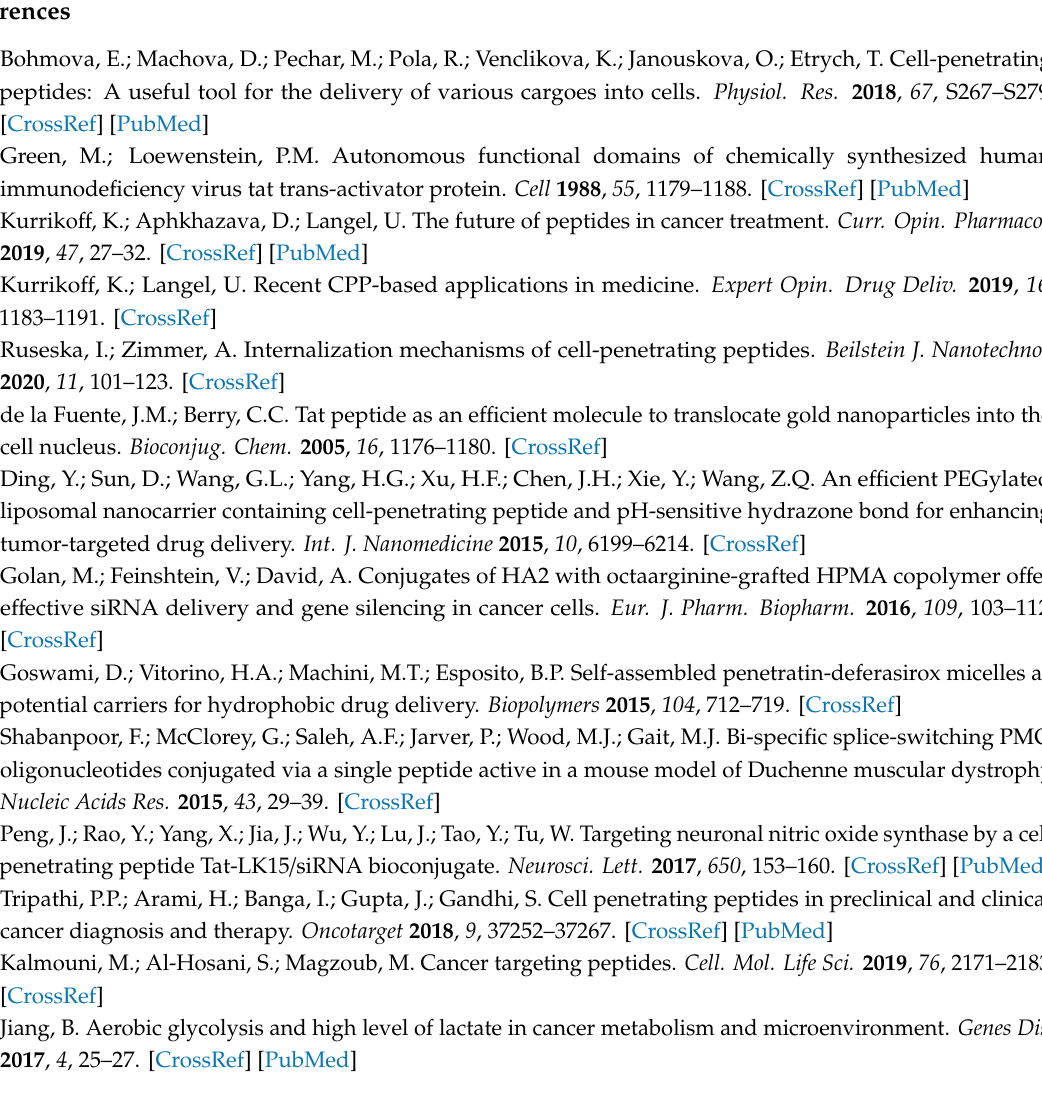
each condition, adj. p -value ≤ 0.05 is marked by grey color, upregulated genes (log2(FC) ≥ 0.5) are marked by green color and downregulated genes (log2(FC) ≤ − 0.5) are marked by red color, Table S3: Clustering analysis of transcriptomic data, Table S4: Quantitative RT-PCR data for Figure S1, Table S5: Gene ontology analysis result for all up- and down-regulated genes after 1- and 4-h treatment related to Figure S2, Table S6: Gene ontology analysis result for only up- or only down-regulated genes after 1- and 4-h treatment related to Figures 2 and 3, Table S7: Gene ontology analysis result for up- and down-regulated genes found in the intersection between di ff erent CPPs after 4-h treatment related to Figure S3, Table S8: List of all annotated LncRNAs found in the analysis. Author